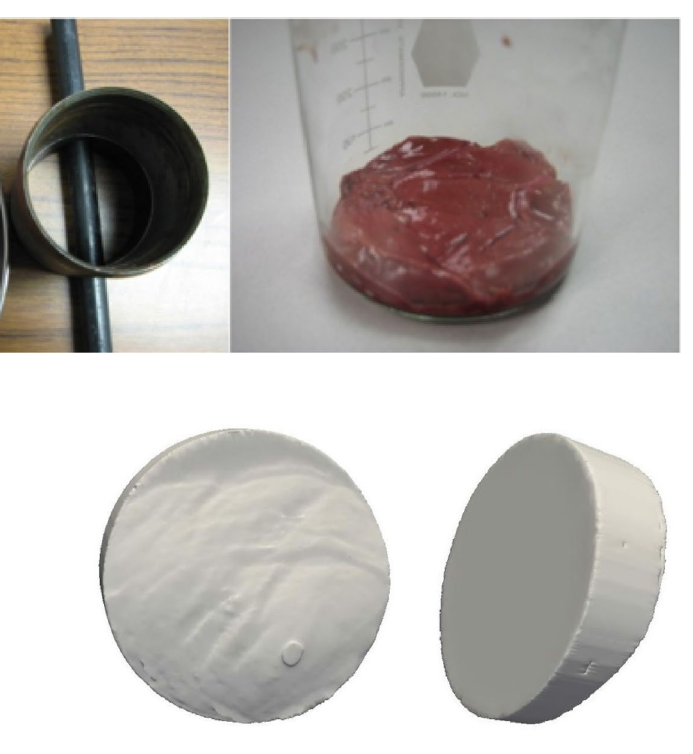
Fig. 3. 3D model from